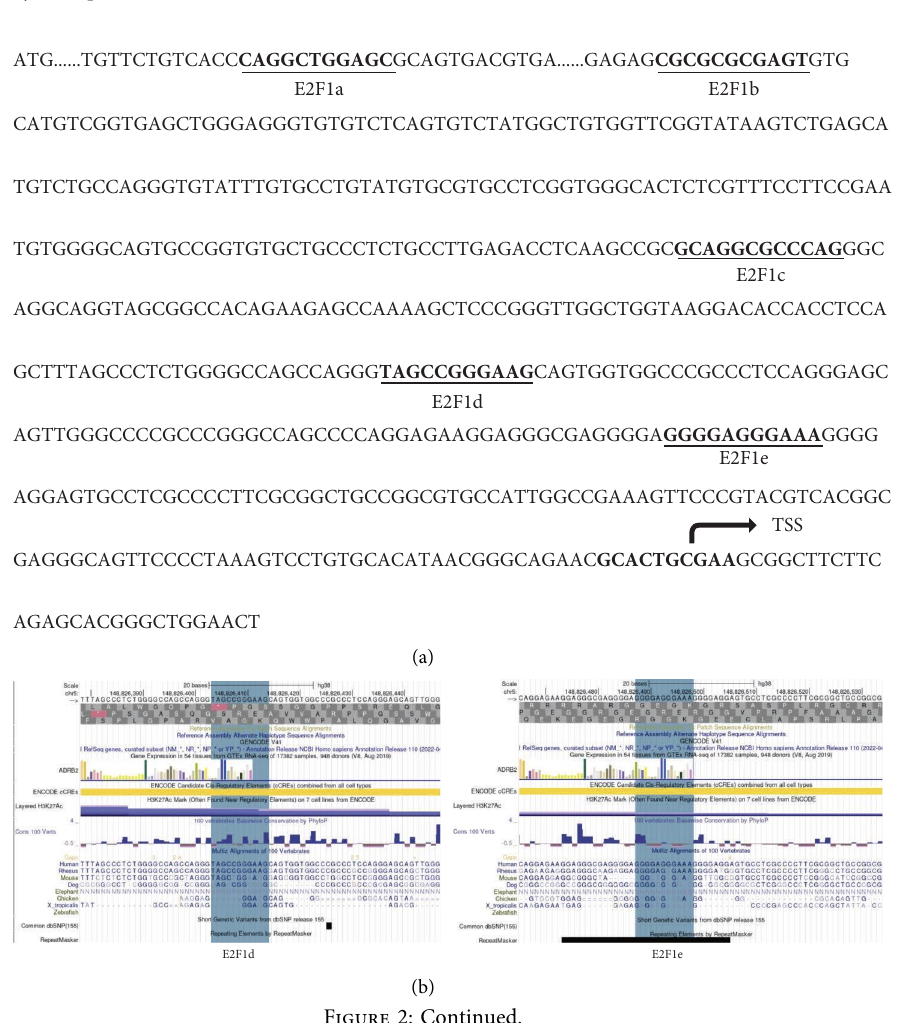
Figure 1: Construction and identifcation of the human ADRB2 promoter. A549 and BEAS-2B cells were seeded in 96-well plates, followed by transfection with pGL-1879/+39 and pGL3-basic. After 24h, the relative luciferase activities were detected. Compared to the pGL3-basic, the activity of pGL-1879/+39 was markedly enhanced in A549 ((a) ∗∗ P < 0 . 01) and BEAS-2B ((b) ∗∗∗ P < 0 . 001). All the experiments were performed independently in